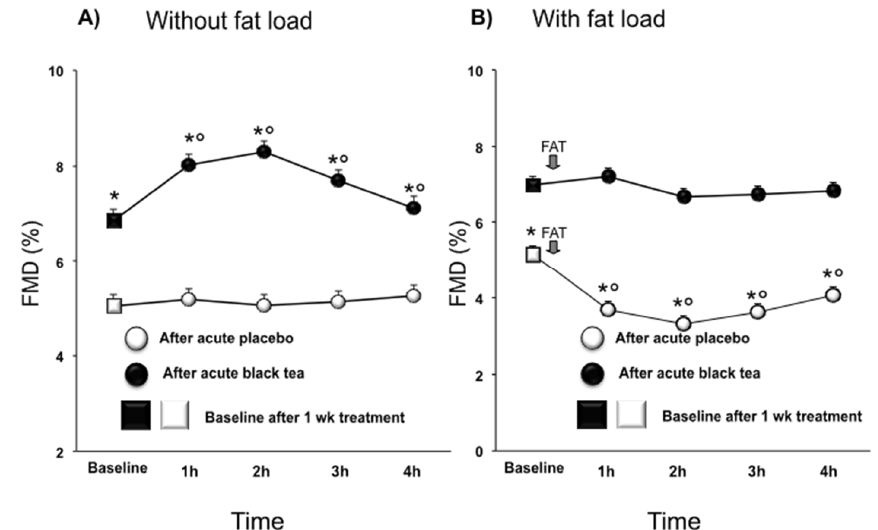
Figure 1. Effect of a 1 week placebo ( white ) and black tea ( black ) administration on baseline (square) values ( A , B ) of flow-mediated dilation (FMD) and acute effects without and with fat load ( A , B ). Data are presented as LSmeans ± SE. In all panels, vertical lines indicate SE, and asterisks (*) indicate significant differences with respect to the placebo phase ( A , B ), while circles (°) indicate significant differences from the baseline values ( A , B ). Differences are considered significant when p < 0.05.